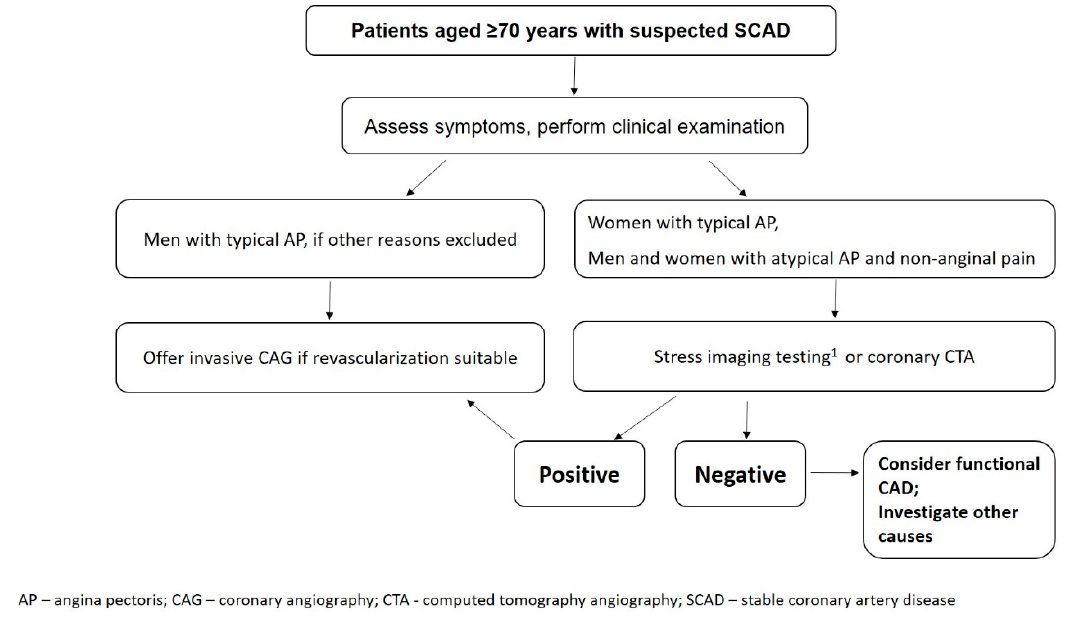
Figure 1. Diagnostic management of older adult patients with suspected SCAD.